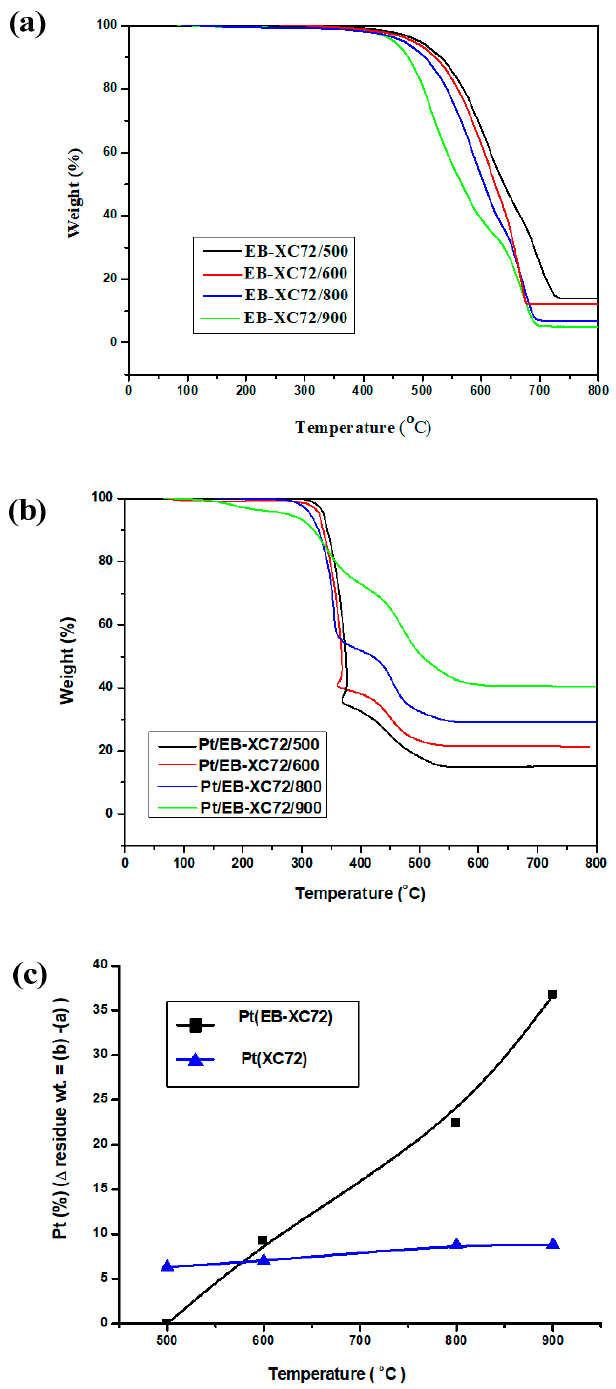
Figure 4. TGA thermograms and Pt-loading % of Pt/EB-XC72 treated at various temperatures. ( a ) EB-XC72, ( b ) Pt/EB-XC72, and ( c ) Pt-loading % of various Pt-catalysts.